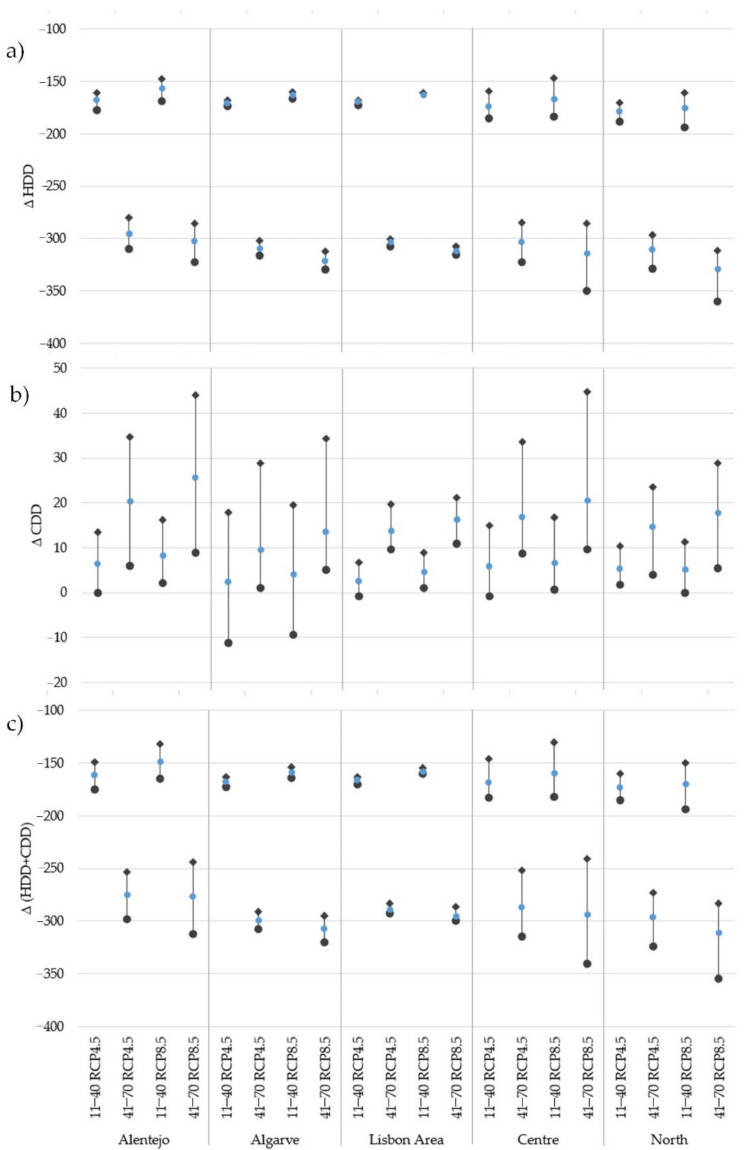
Figure 11. Mean (blue dot), Maximum (black square) and Minimum (black dot) values for the anomalies by region (NUTS II) for 2011–2040 and 2041–2070 and both emission scenarios. ( a ) HDD, ( b ) CDD, and ( c ) HDD + CDD in ◦ C × D per